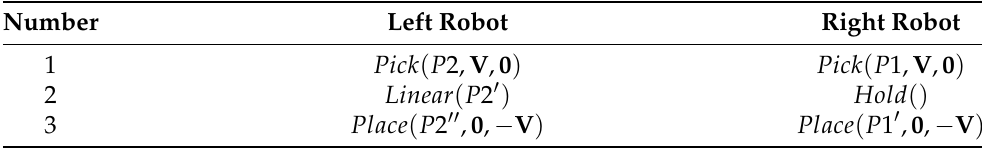
Figure 3. Schematic diagram of dual-robot cooperative disassembling for terminal with wire. Table 2. Example of action